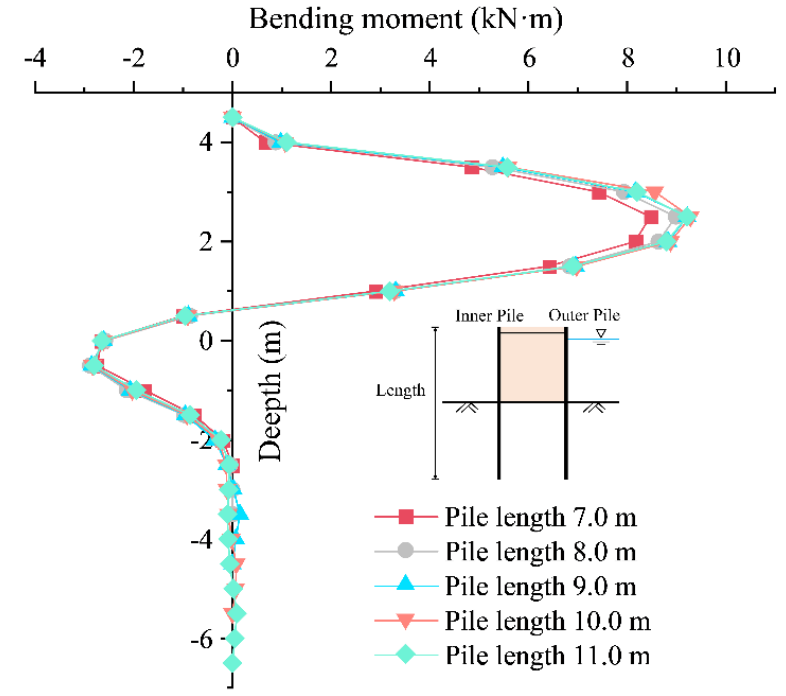
Figure 13. Pile bending moment of different pile length conditions.